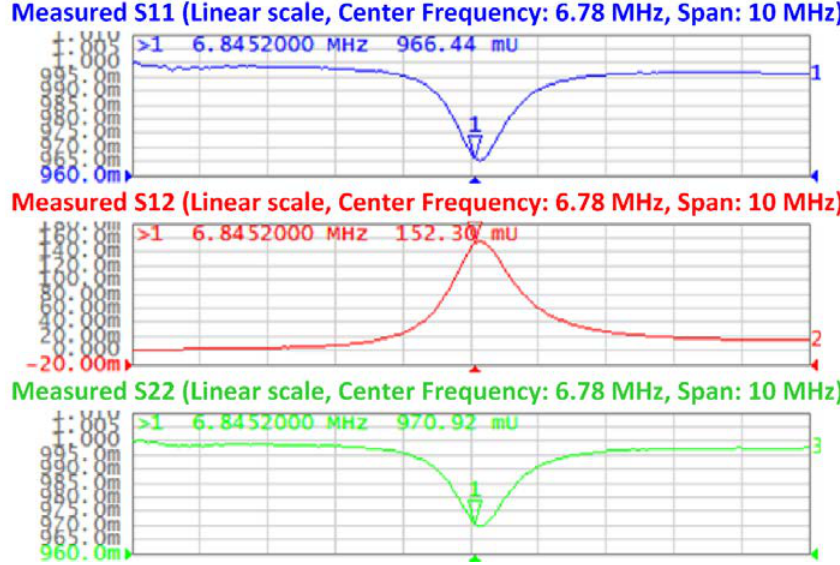
Figure 8. Measured S-parameters of the transmitter and receiver coils.